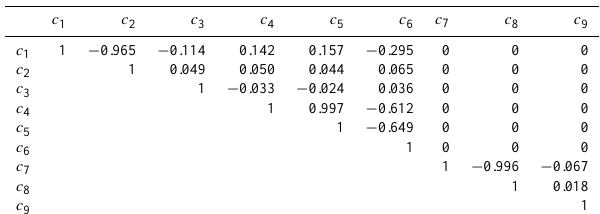
Table A3. Symmetric linear correlation matrix of fit parameters of Eq. (8) (normal compaction, with fluid flow). The number of fit- ted simulations is n = 363; χ 2 = 413265.3; variance of residuals is 1167.4kgm − 2 ; linear correlation coefficient for GH FF from model simulations and fitted equation is r 2 = 0.9620.